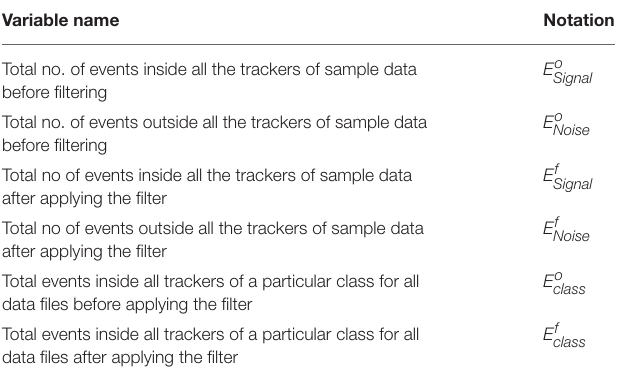
TABLE 3 | Definition and notation of the variables used in the metrics